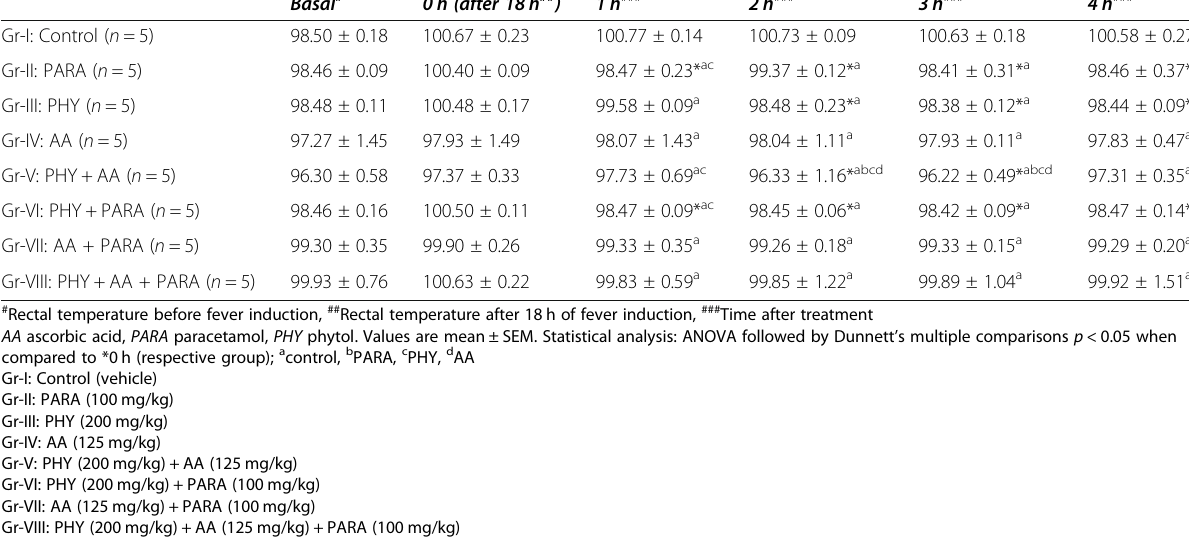
Table 2 Anti-pyretic effects of phytol and/or ascorbic acid and controls in Brewer ’ s yeast-induced pyrexia in mice